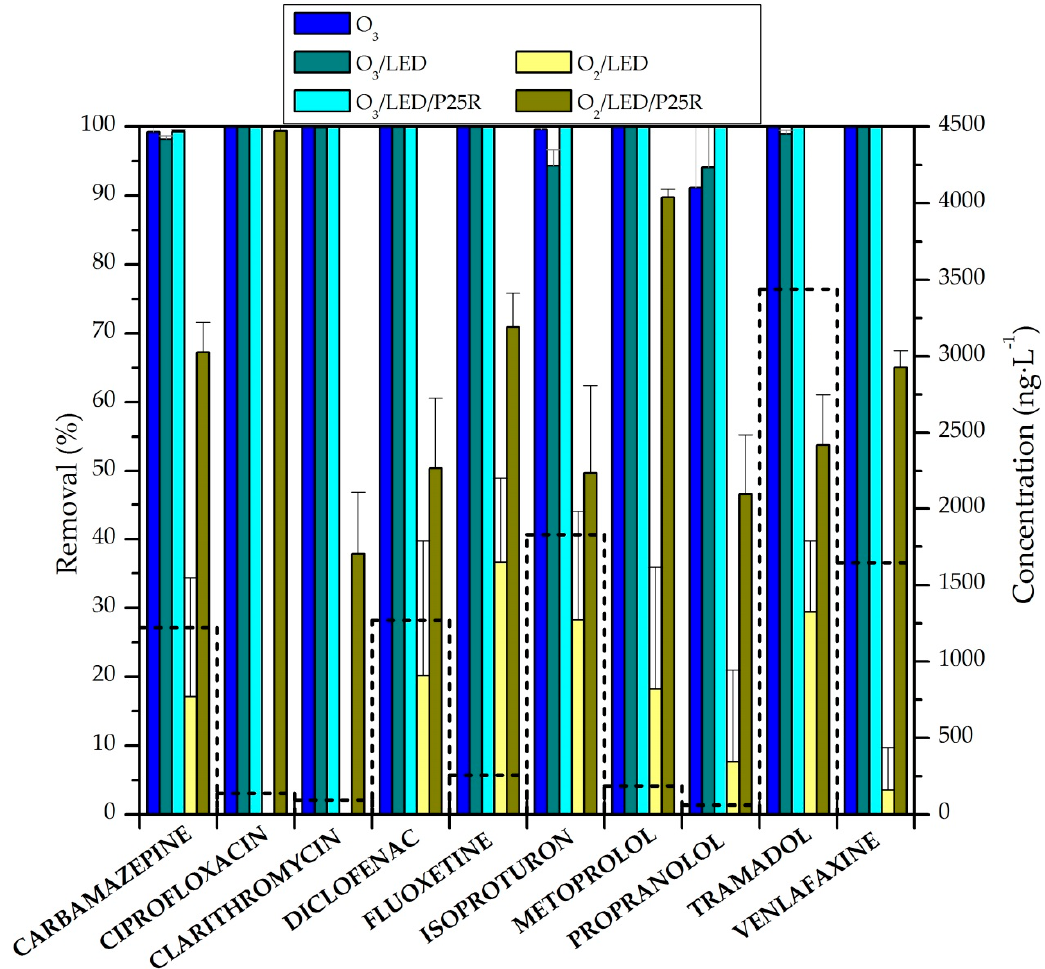
Figure 2. Average removal at steady-state (left axis, solid bars) and inlet concentrations of CECs (right axis, dotted bars) in di ff erent continuous flow experiments. Conditions: Hydraulic retention time (HRT) = 39 min; recirculation ratio = 9:10; gas flow rate = 150 mL · min − 1 ; ozone gas concentration (when applied) = 20 mg · L − 1 ; P25R loading c.a. 0.29